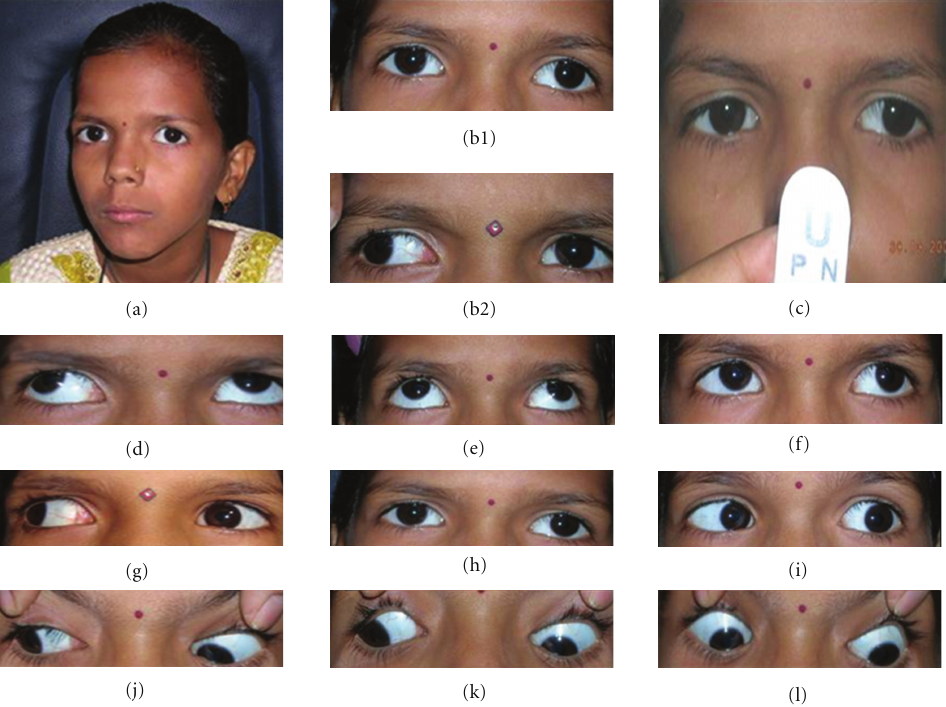
Figure 1: Digital face photographs of the patient demonstrating (a) orthotropia with right face turn, (b1) left eye exotropia in forced primary position when fixing with the right eye, (b2) increase in the deviation while fixing with the left eye, (c) absence of convergence, (d–l) ocular movements in cardinal positions of gaze.